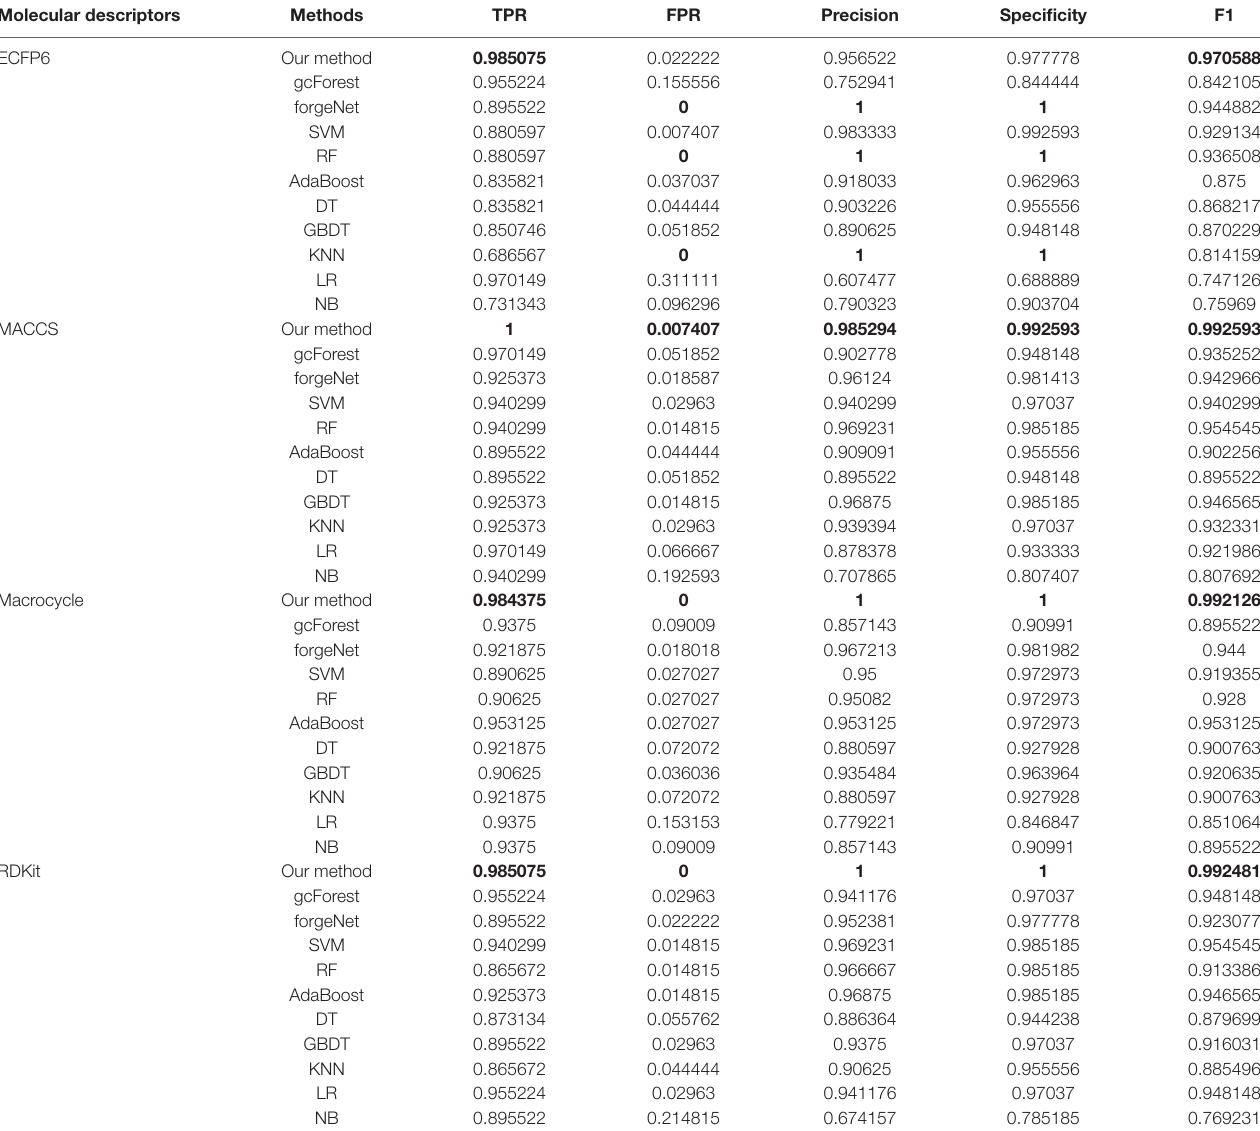
TABLE 1 | Prediction performances of 11 methods with hypertension